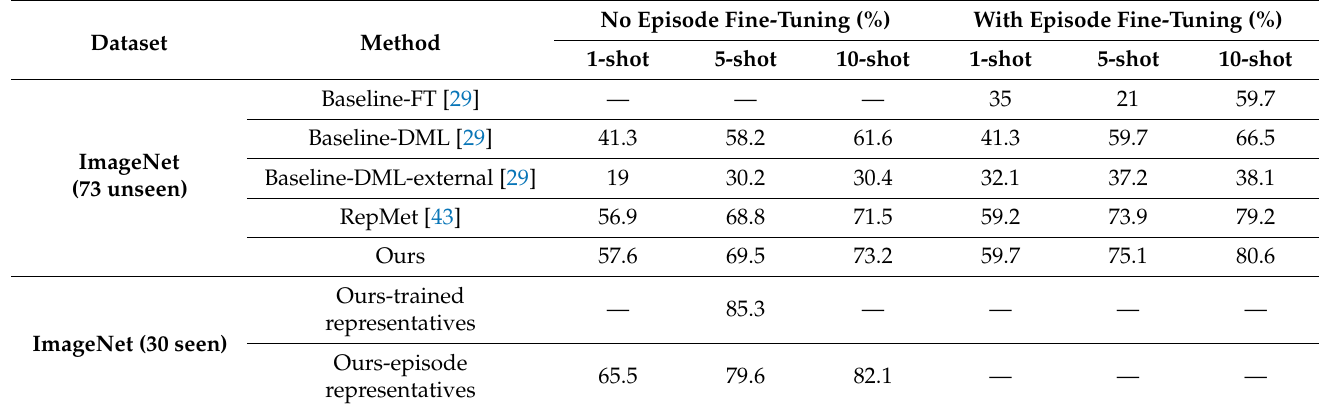
Table 3. Comparison of mAP results of 5-way few-shot detection with the baseline methods.